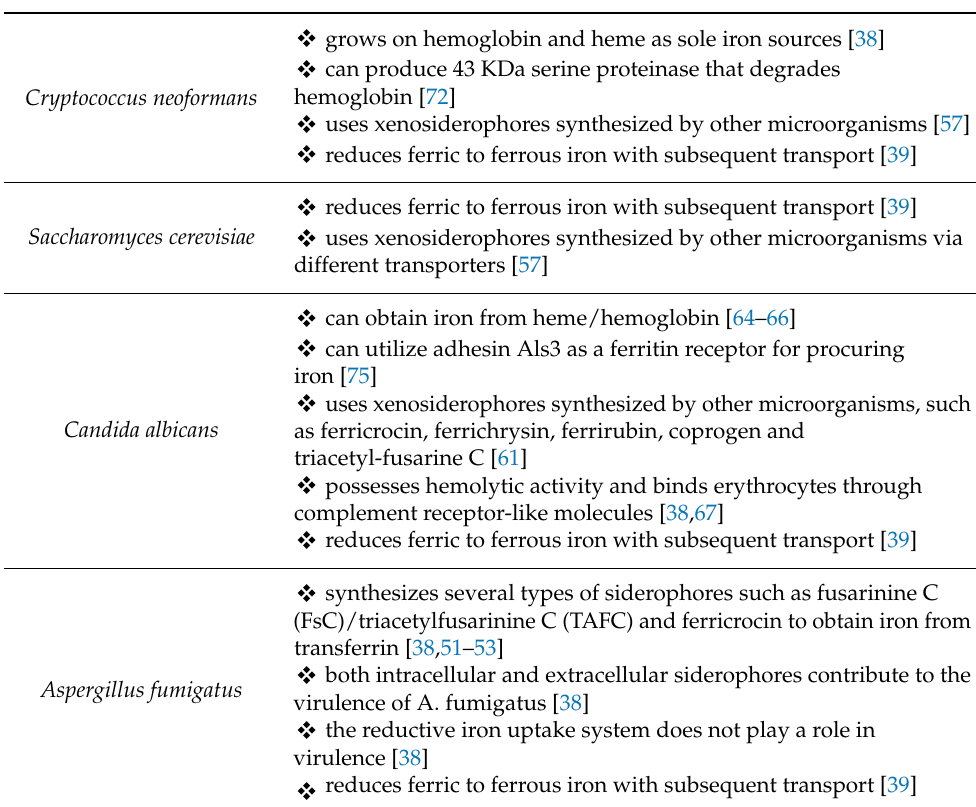
Table 1. Mechanisms of iron acquisition by fungal pathogens.